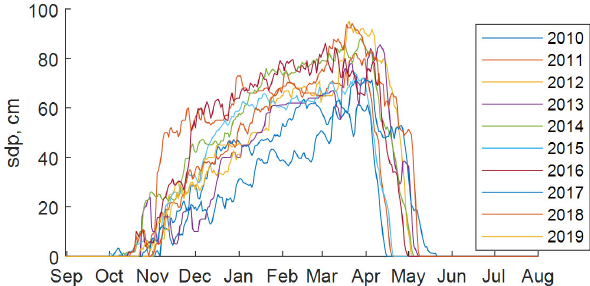
Figure 5. Daily snow depth for